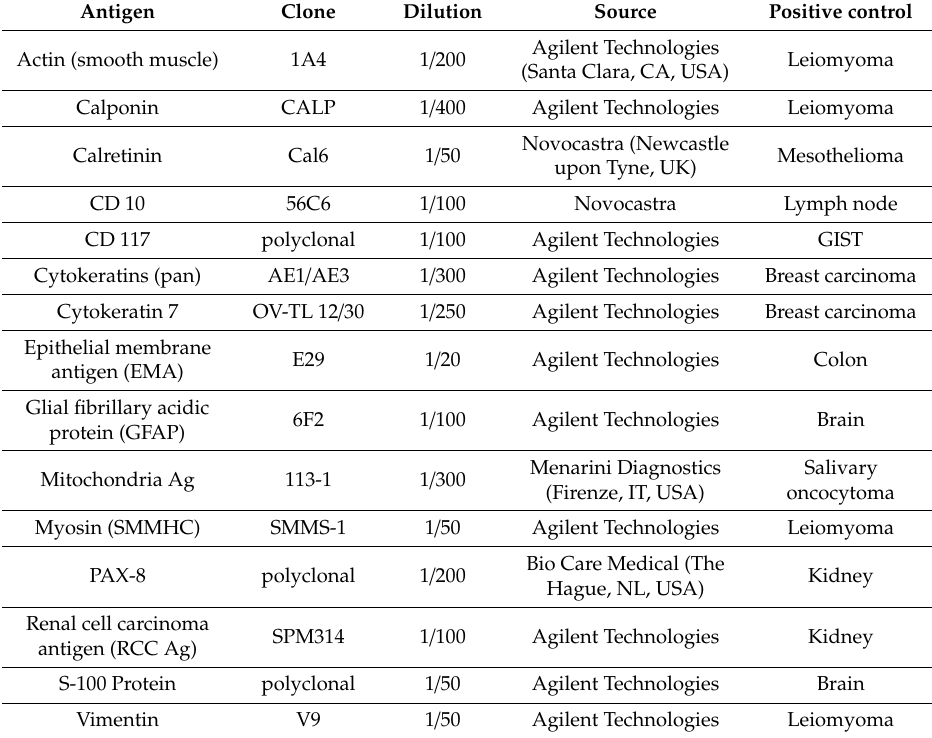
Table 1. Pertinent data of the monoclonal antibodies used to immuno-characterize metastatic clear cell renal cell carcinoma.